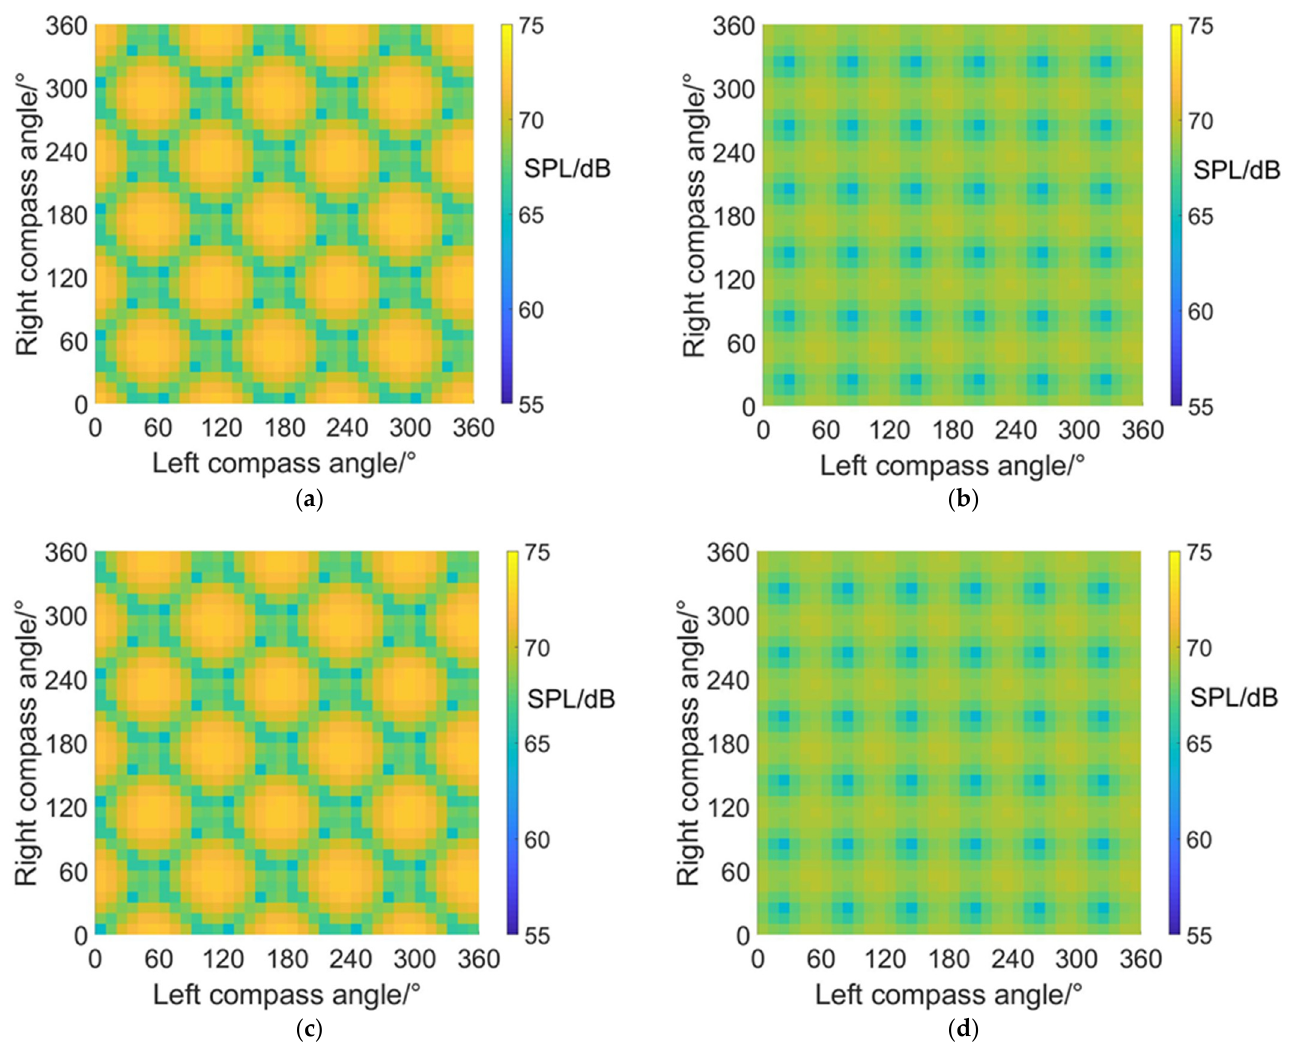
Figure 14. Carpet diagrams of noise SPL in fixed-wing mode at an azimuth angle = 90° with scissors